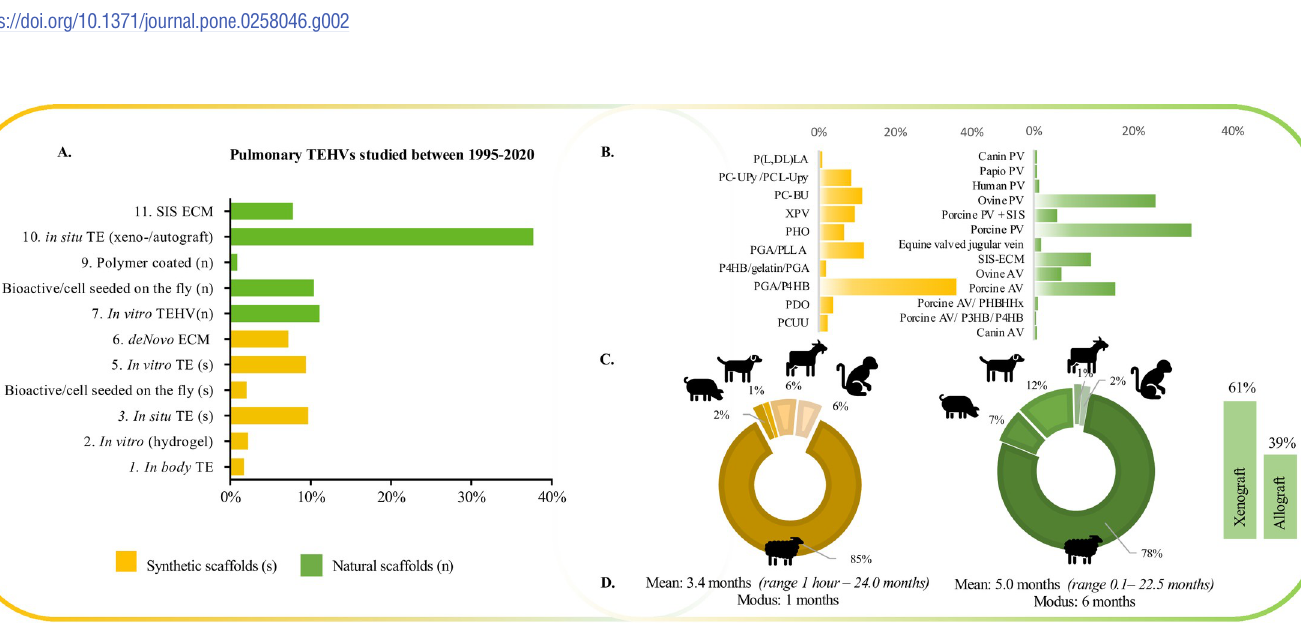
PLOS ONE | https://doi.org/10.1371/journal.pone.0258046 October 5, 2021 6 /